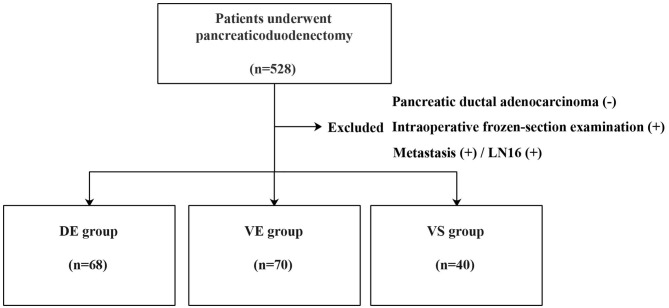
Flow chart of inclusion: DE patients with tumor located in the dorsal head of the pancreas performed with extended lymphadenectomy; VE patients with tumor located in the ventral head of the pancreas performed with extended lymphadenectomy; VS patients with tumor located in the ventral head of the pancreas performed with standard lymphadenectomy.